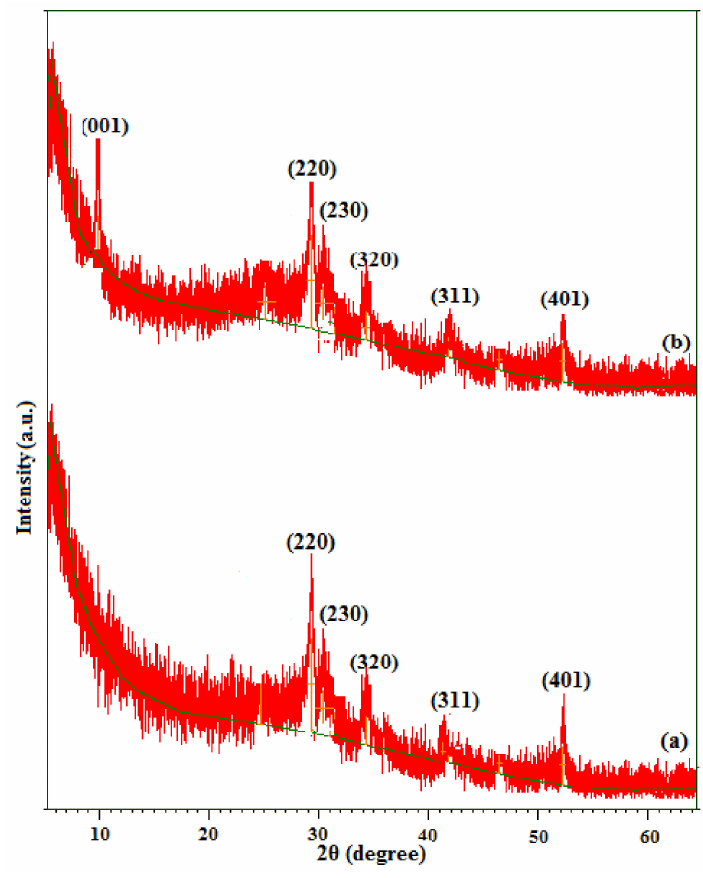
Figure 1. XRD patterns of ( a ) CaFe 2 O 4 and ( b ) CaFe 2 O 4